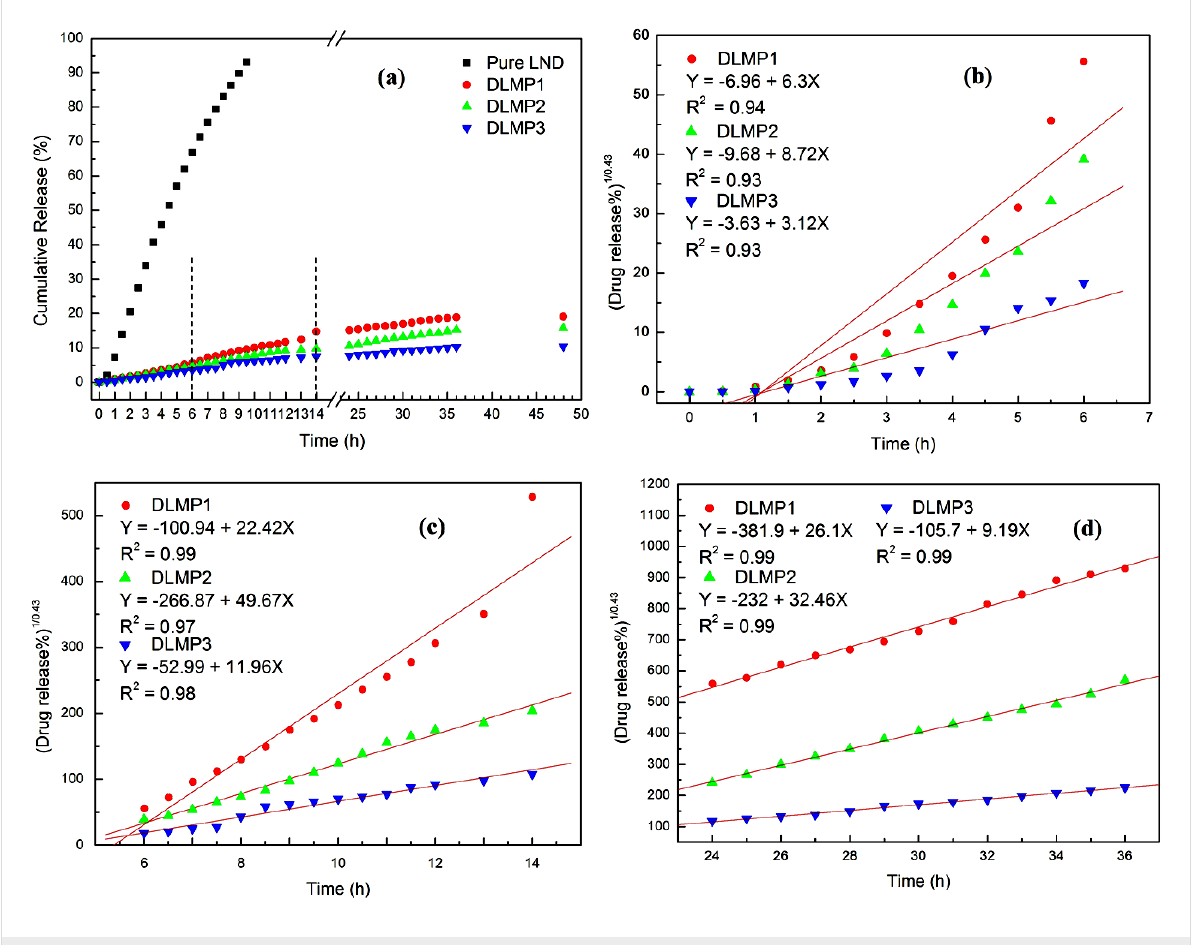
Figure 6: Release profiles (a) and release kinetics (b–d) of LND from DLMP1, DLMP2 and DLMP3 in buffer solution at 37 °C.